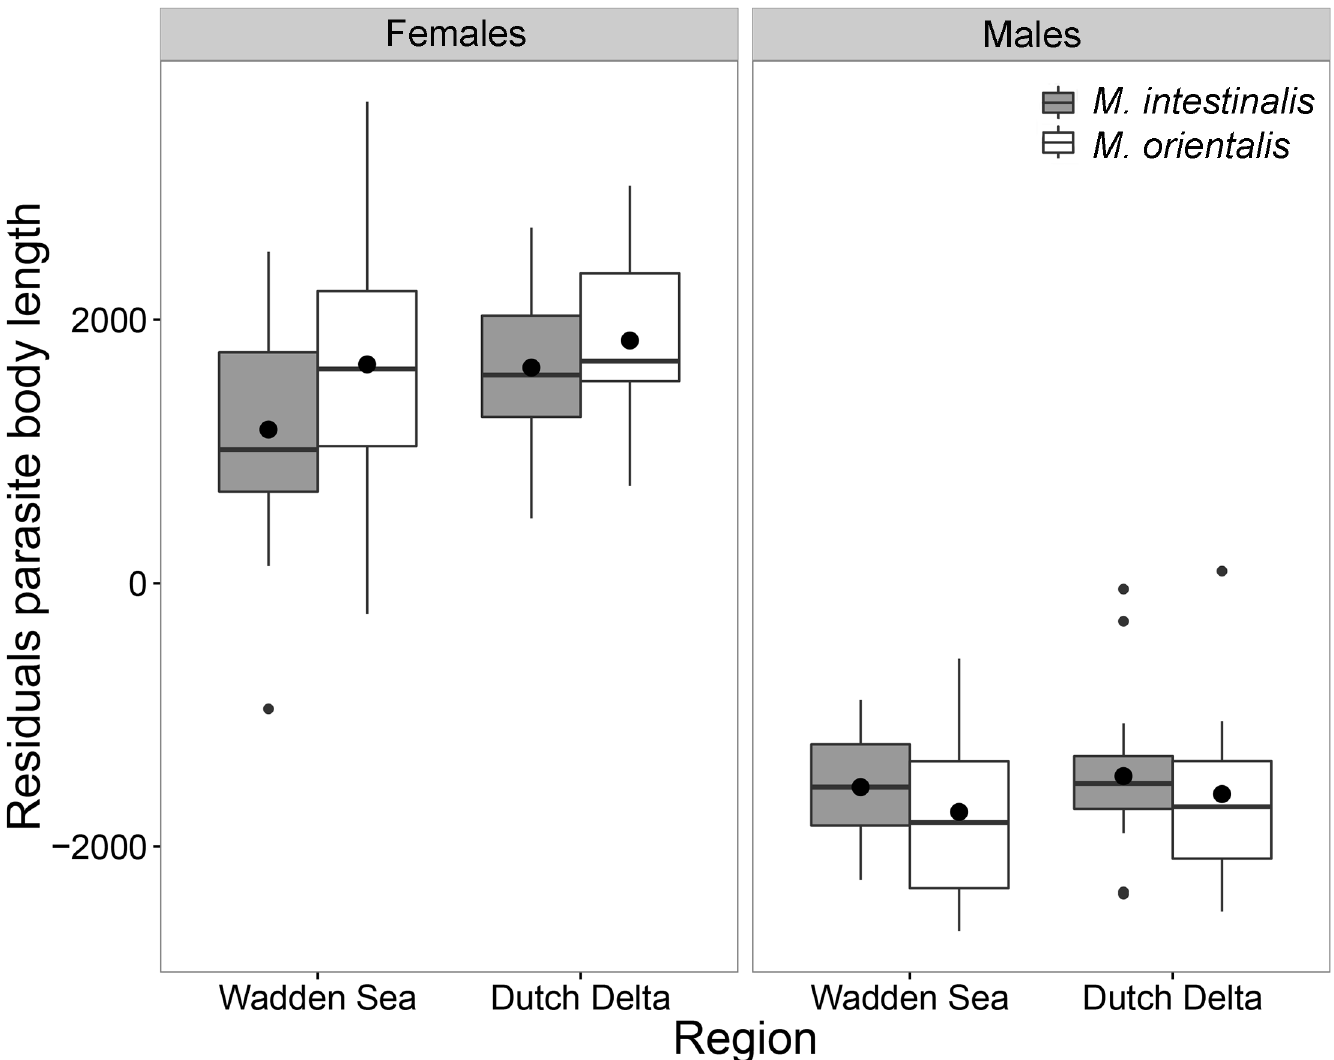
Fig 5. Parasite body length (corrected for host size using linear regression) for both introduced Mytilicola species. Females (left) and males (right) of M . intestinalis (grey) and M . orientalis (white) in each surveyed region. The boxes represent the interquartile range, the whiskers denote the lowest and highest values within the 1.5 interquartile range, the black line in each box denotes the median, the large black dots represent the mean and the smaller dots outside the boxes are